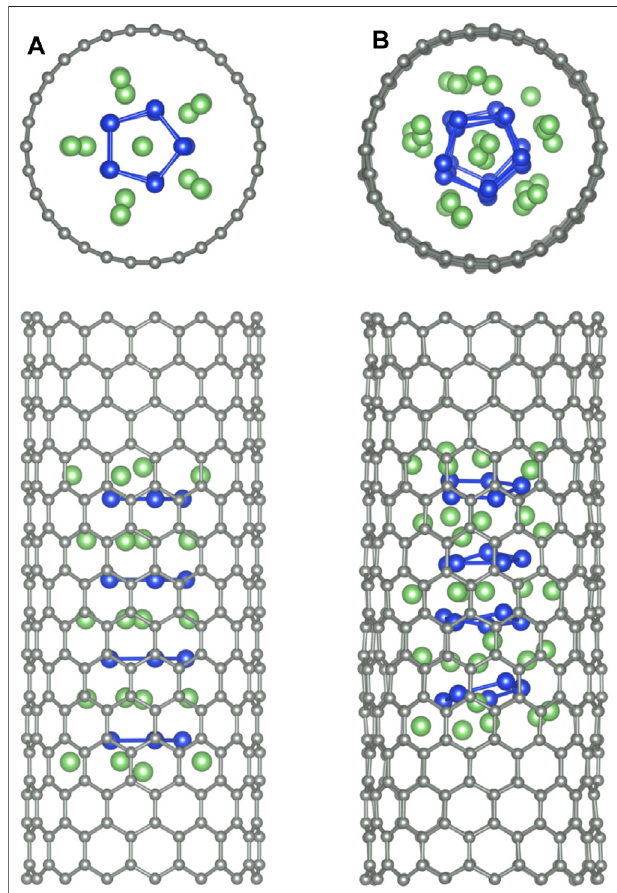
FIGURE9| Thef-Li 6 Si 5 structureinsideazigzag(15,0)CNT. (A) Topand side views of the equilibrium geometry at 0 K. (B) Top and side views of a snapshot taken at 2000 fs of BO-AIMD simulation at 300 K. The periodicity of the CNT along its axis is z 0 (cid:2) 30 Å.